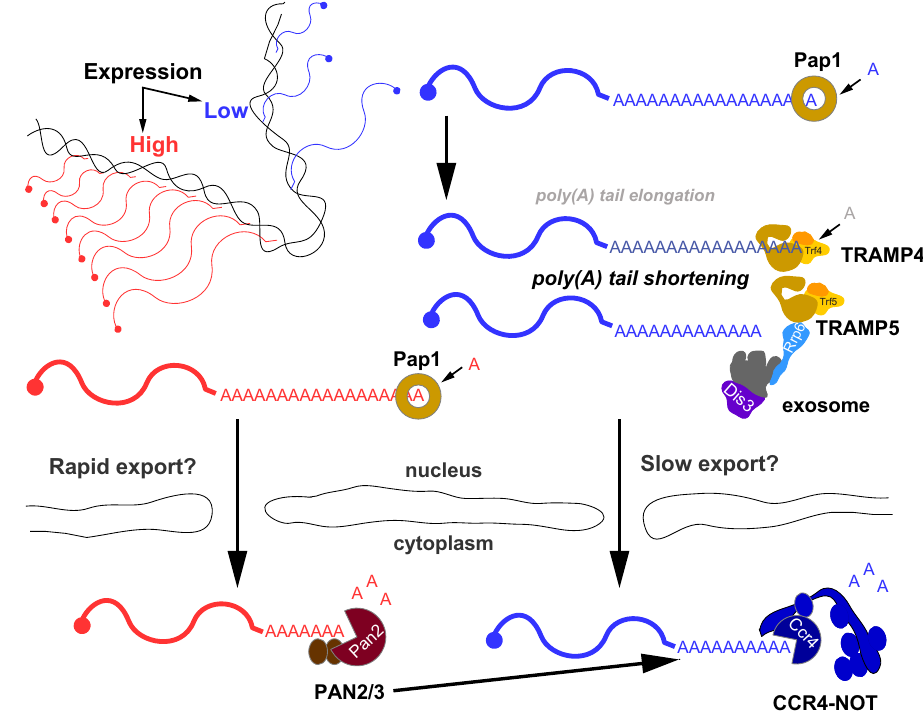
Fig. 7 mRNA poly(A) tail length is extensively regulated post-transcriptionally in both the nucleus and the cytoplasm. For details, see “ Discussion ”